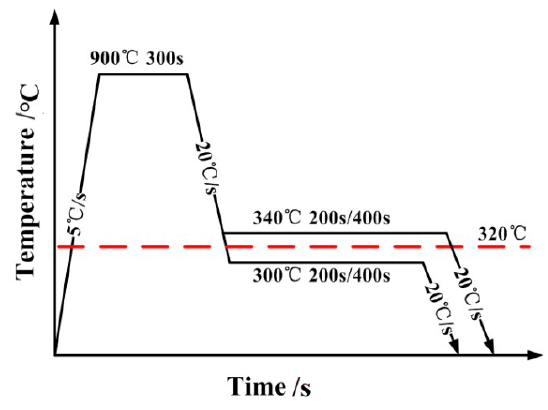
Figure 2. The experimental procedure.